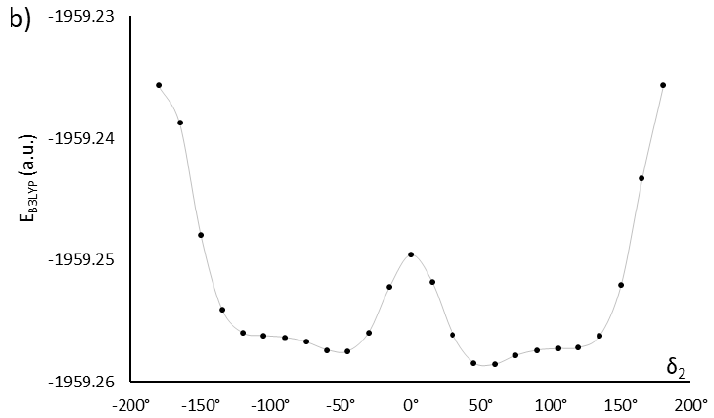
Figure 3. Energy changes in relation to the mutual orientation of phenyl rings and ester groups, described by dihedral angles δ 1 ( a ) and δ 2 ( b ) in AU12 monomer. The solid lines are guides to the eye.